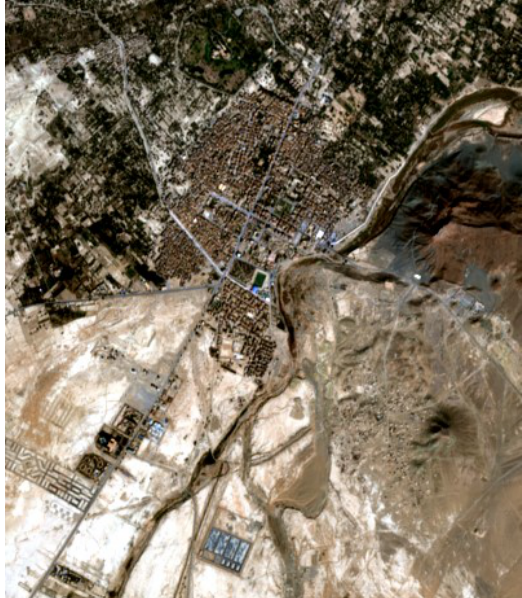
Figure 2. Erfoud town satellite image: Sentinel-2 visible data